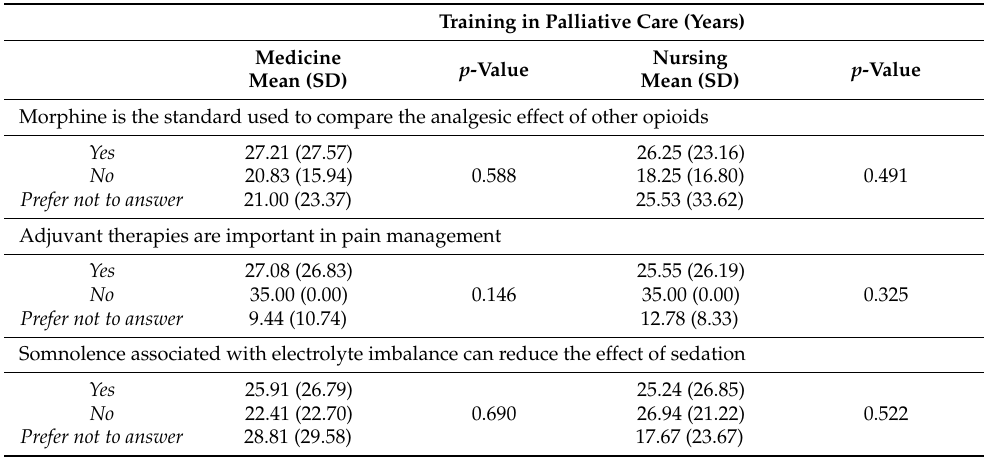
Table 7. Physicians’ and nurses’ knowledge according to hours of training in palliative